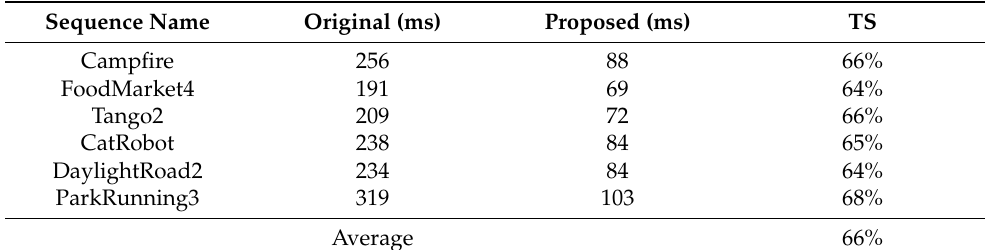
Table 5. Comparison of the extraction times for H.264/AVC bitstreams. TS: time